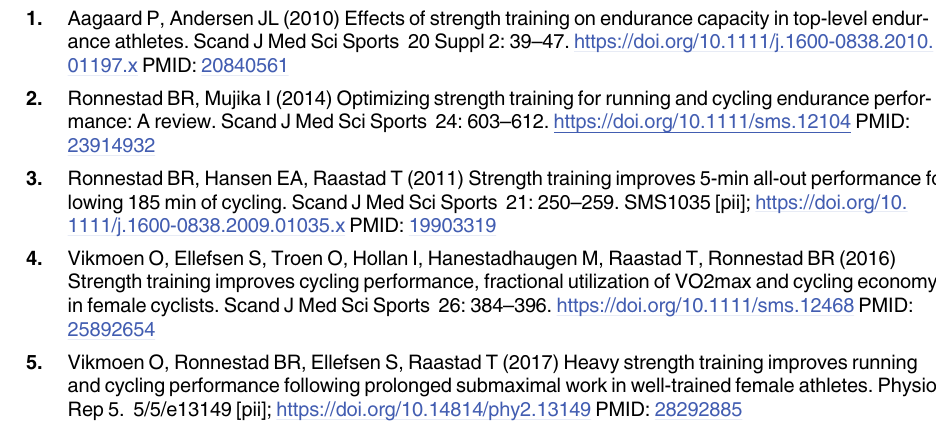
S1 Table. Baseline values and changes (delta) within each